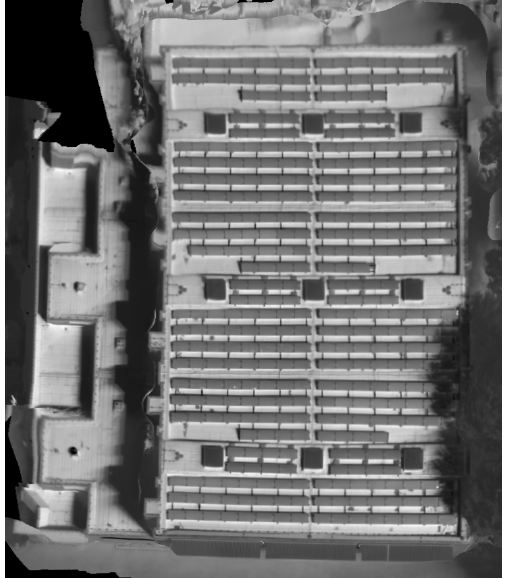
Figure 8. Point cloud generated in the bundle adjustment. One can see the convex roof and the solar cells on top. On the right, there are points belonging to the trees and in the front there are points belonging to other roof parts of the gym and the ground.